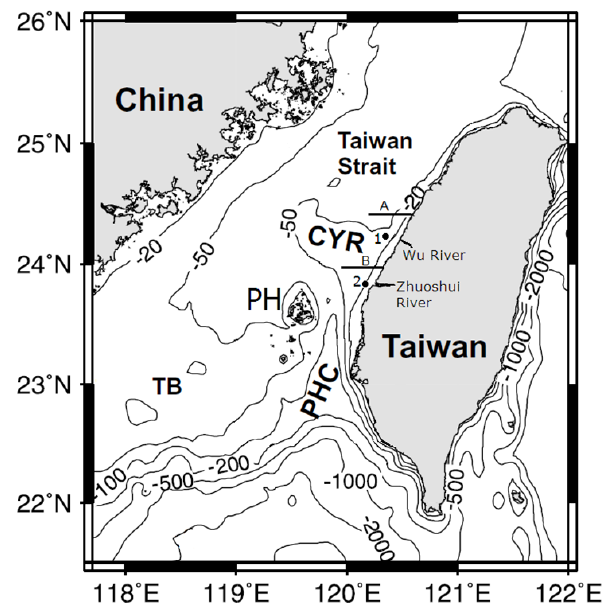
Figure 1. Bathymetry of Taiwan Strait. TB is Taiwan Bank, PH is Peng-Hu Archipelago, CYR is the Chang-Yuen Ridge, PHC is the Peng-Hu Channel (modified from Jan and Chao, 2003). Points 1 and 2 indicate the locations of the sites we refer to in the discus- sion. The mean water depths at sites 1 and 2 are 33m and 13m, respectively. Zonal transects A and B we refer to in the discussion of buoyant destruction of turbulent kinetic